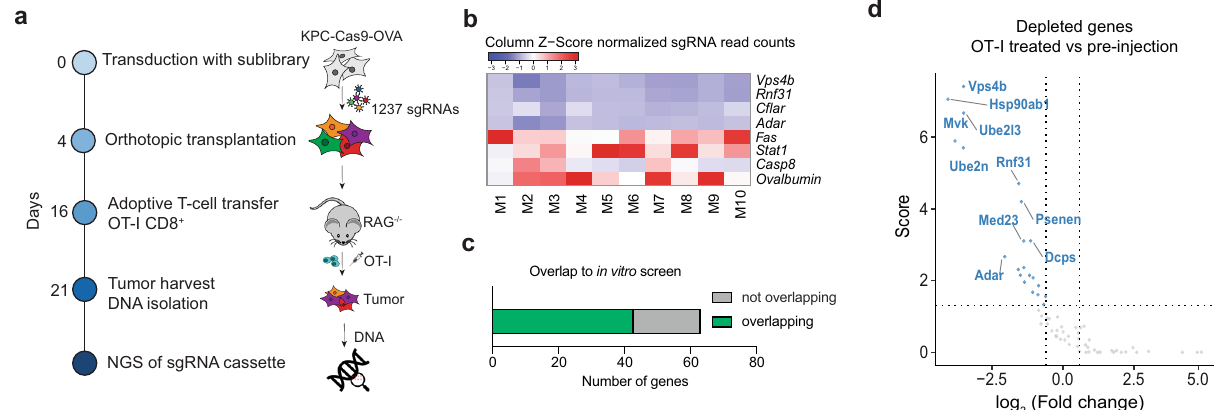
Fig. 2 A targeted CRISPR library screen validates candidates in vivo. a Schematic of the secondary CRISPR screen in vivo. b Heatmap of normalized read counts of sgRNAs across ten individual mice (M1 – M10). c Bar diagram of sublibrary genes in comparison to their predicted phenotype (from in vitro screen). d Volcano plot of depleted (blue dots) genes of the sublibrary in vivo screen when comparing the pool of preinjected KPC cells to OT-I CD8 + T cell treated tumors. Sublibrary screening data were derived from a total of ten individual tumors (transplanted mice n = 10), transplanted in two experiments. Source data are provided as a Source Data fi